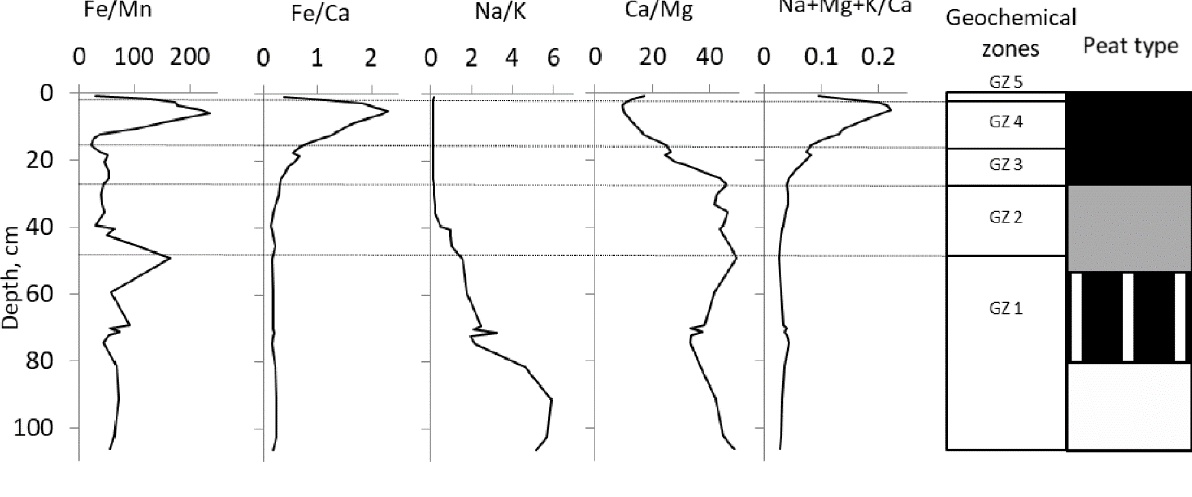
Figure 3. Depth profiles of some geochemical attributes of Core W3. GZ: geochemical zones. Peat type according to Pawełczyk et al . (2017): black = Saprists ; grey = Magnocaricioni, Cariceto-phragmiteti ; striped = Bryalo-Parvocaricioni, Cariceto-Bryaleti ; white =